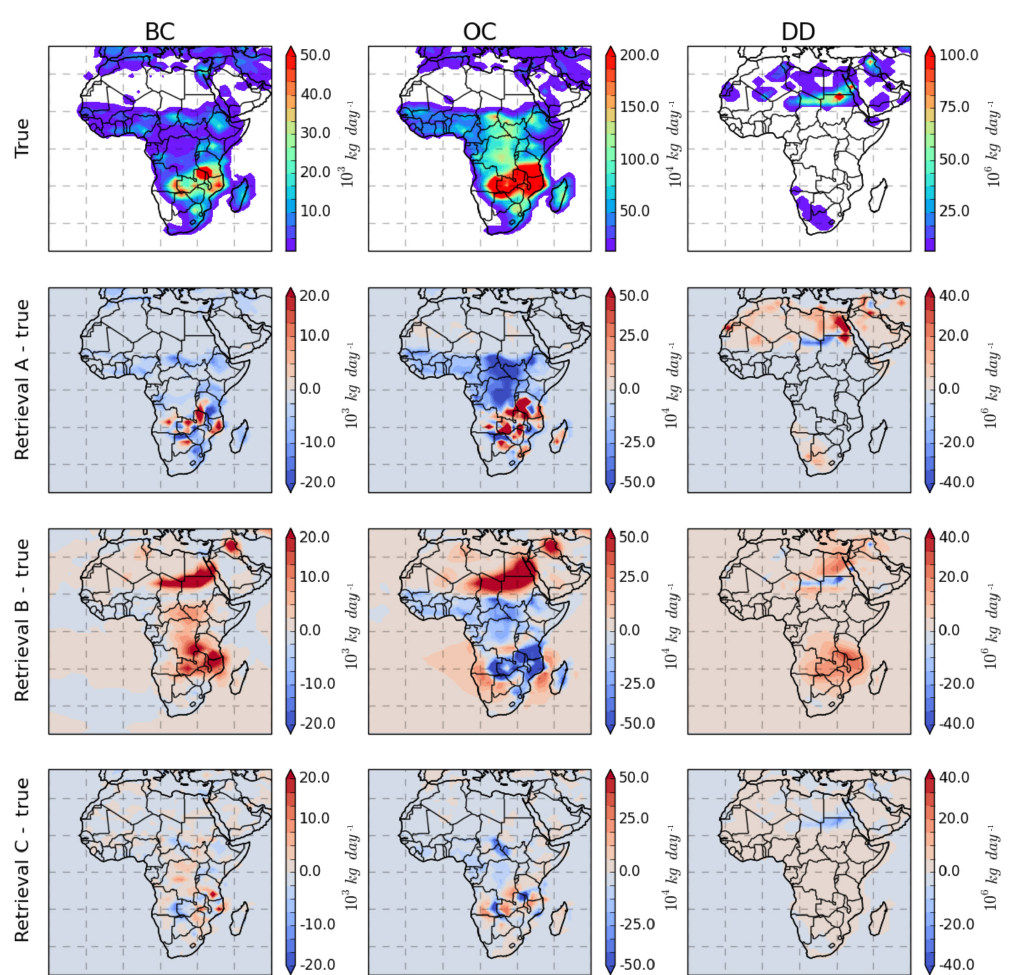
Figure 7. Inversion test for retrieving BC, OC and DD emissions from synthetic measurements with three different initial guess schemes: (A) prior model emissions – Retrieval A; (B) spatially uniform – Retrieval B; (C) prior emissions with spatially uniform background – Retrieval